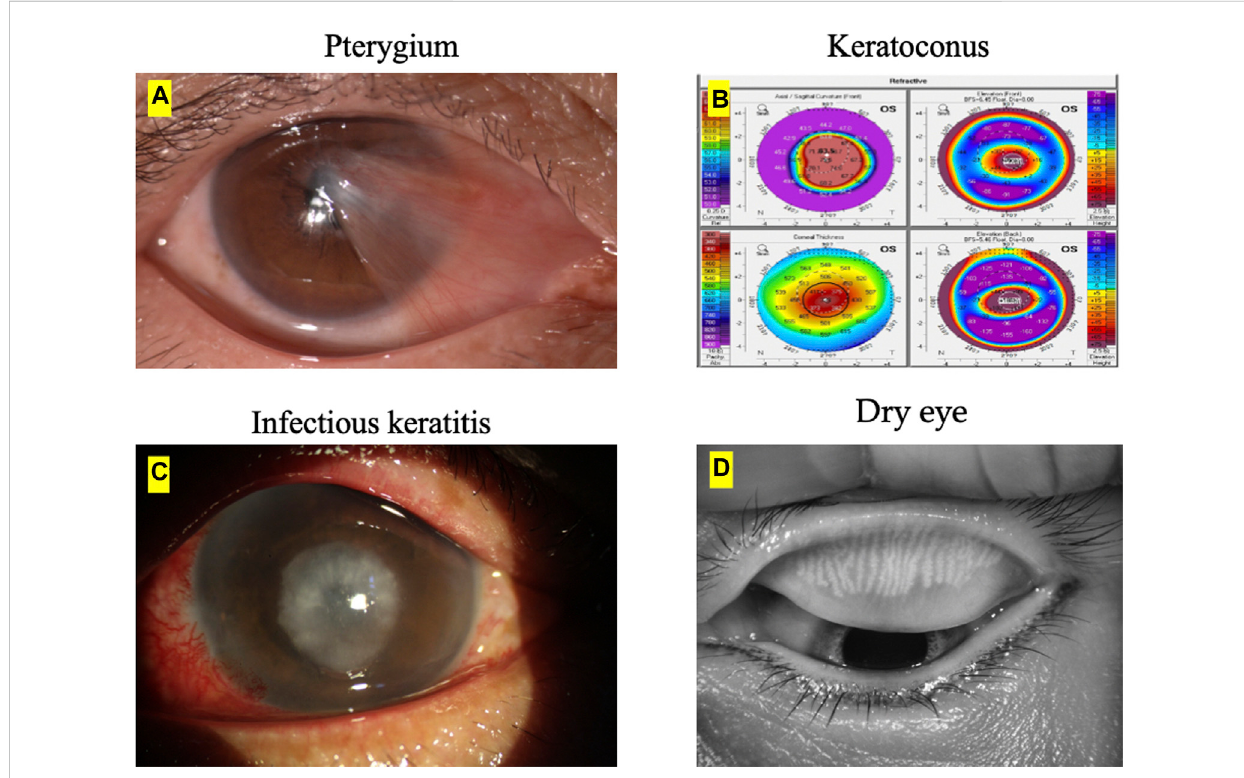
FIGURE 1 Ocular surface diseases and image modalities. (A) The main imaging modality of pterygium is anterior segment photograph. (B) The main imaging modalityofkeratoconusispentacam. (C) Themainimagingmodalityofinfectiouskeratitisisslit-lampimages. (D) Themainimagingmodalityofdryeyeis Keratograph